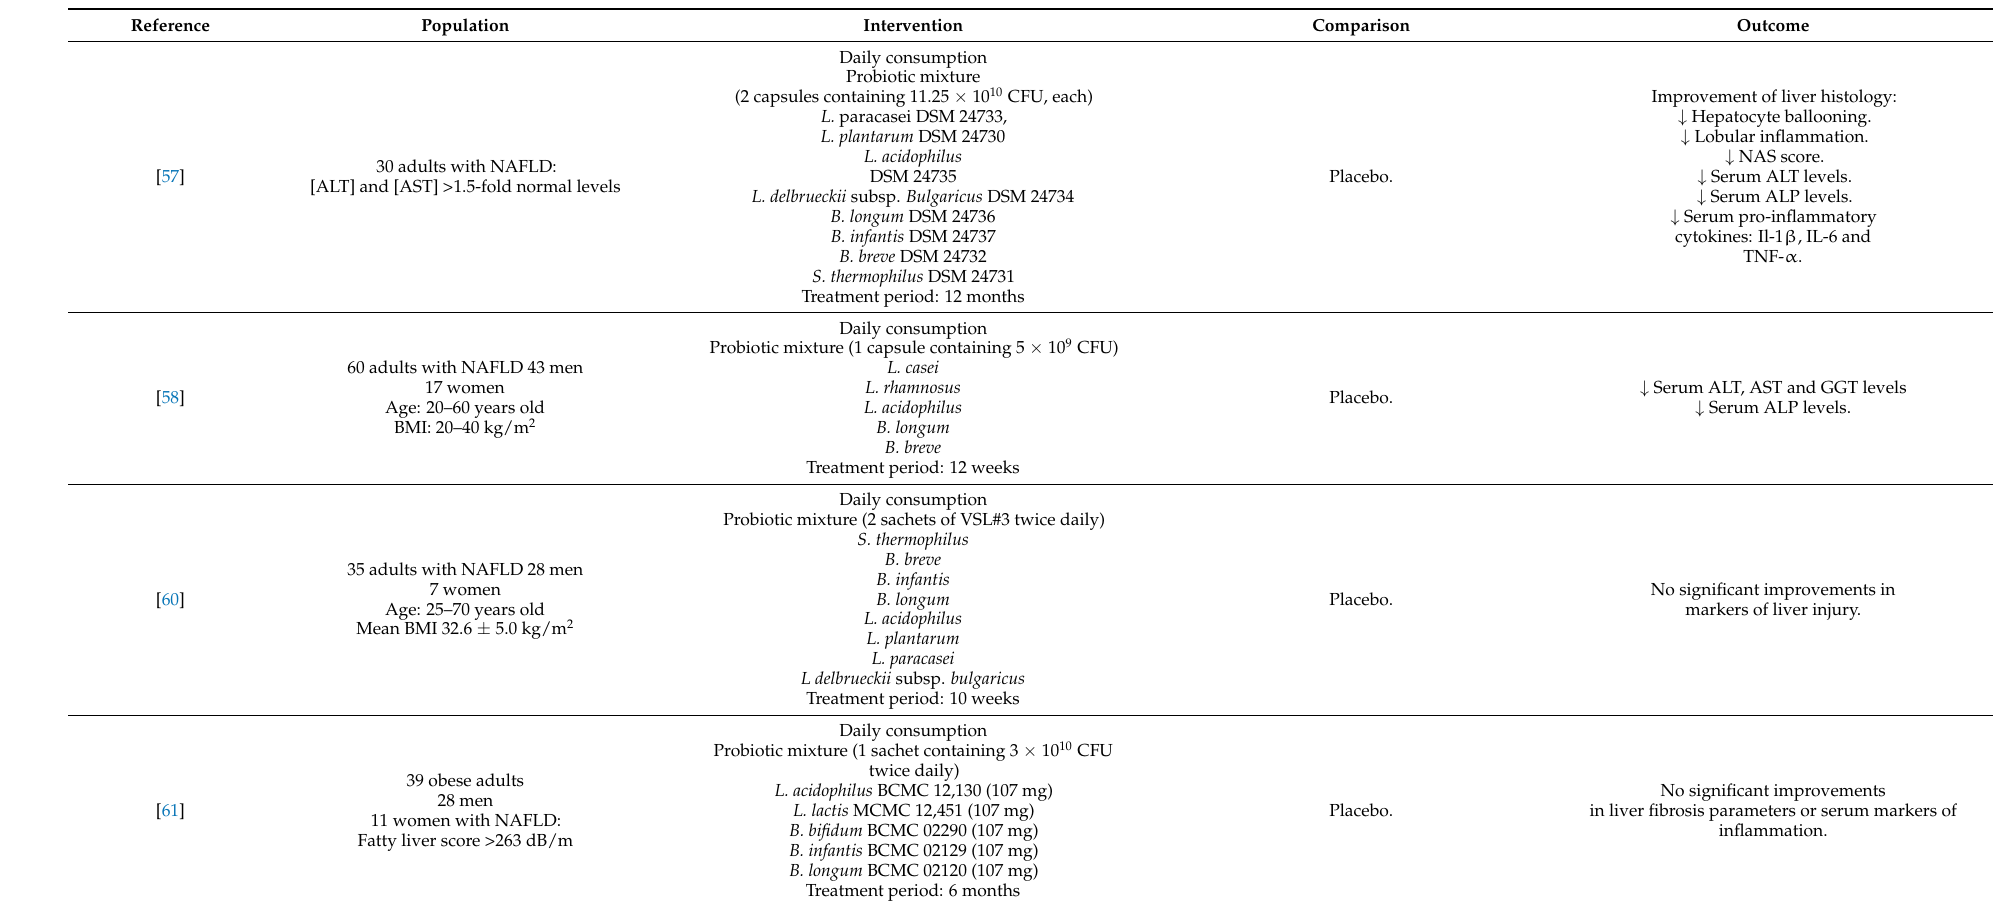
Reference Population Intervention